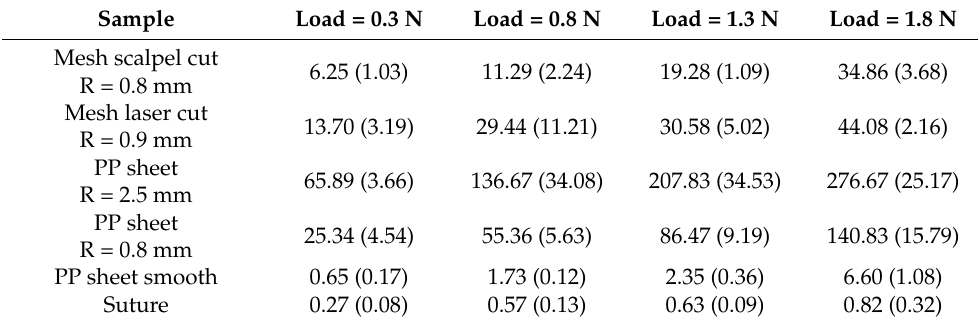
Table 2. Erosion rate (in mm/m) for tests conducted with a stroke length of 20 mm. Averages from at least 5 results per group: standard deviation in brackets.